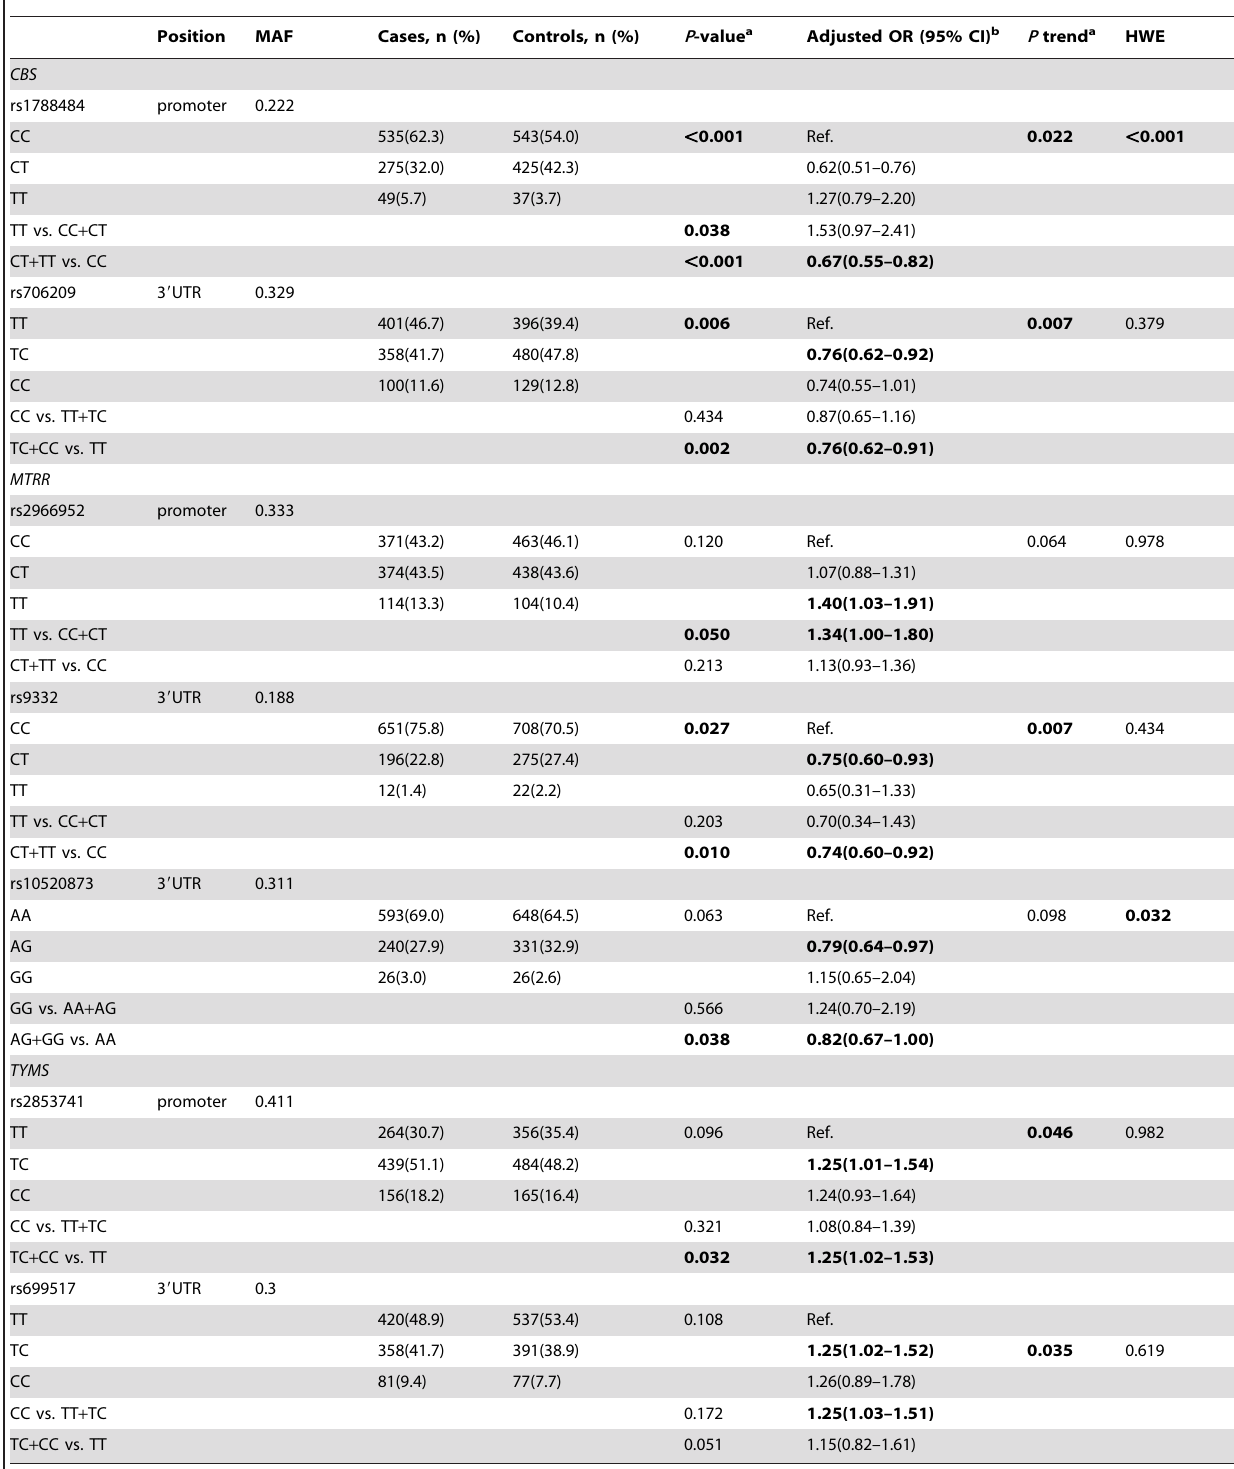
Table 2. Polymorphism in one-carbon metabolism genes and clear cell renal cell carcinoma